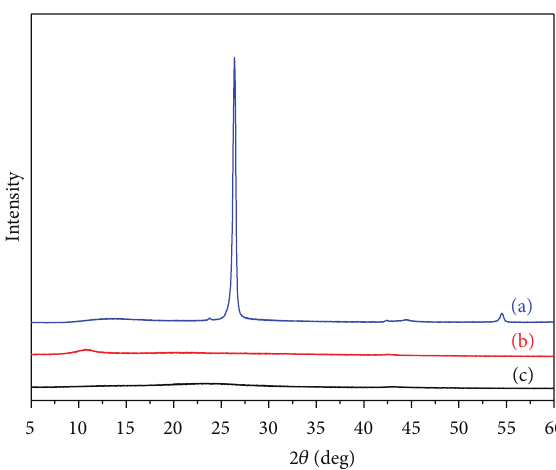
Figure 4: XRD patterns of (a) graphite, (b) XGO, and (c) RGO.